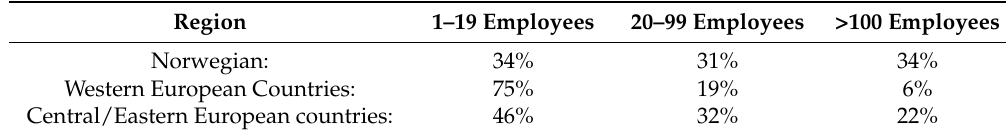
Table 4. Size of the companies of the respondents, according to their nationality group. Per